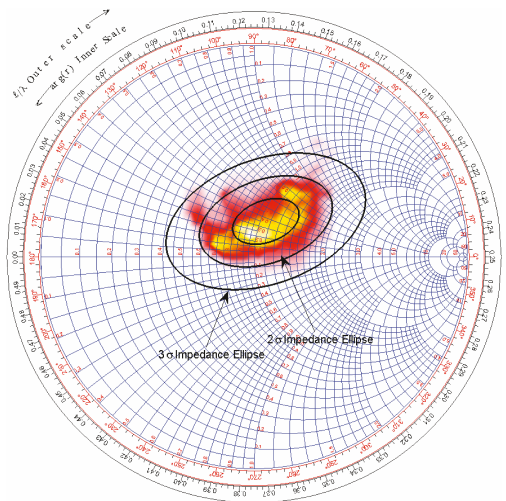
Figure 6: 1 σ , 2 σ , and 3 σ ellipses for the Cantor antenna in UTRA/FDD LTE B8 band.